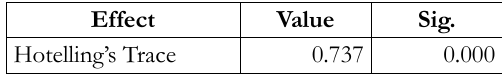
Table 8. Result of Manova